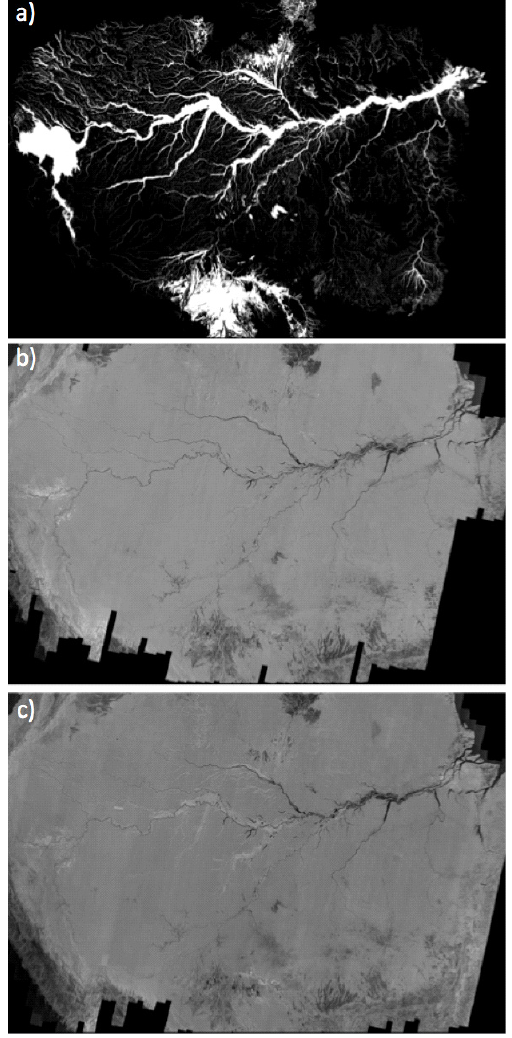
Figure 8. Location shown in Figure 3 by yellow box where horizontal extent is 3500 km. ( a ) JERS-1 SAR-based wetland mask (white is inundatable; black is not) [4]; ( b ) JERS-1 SAR image mosaic—Amazon River low flood (late–1995); ( c ) JERS-1 SAR